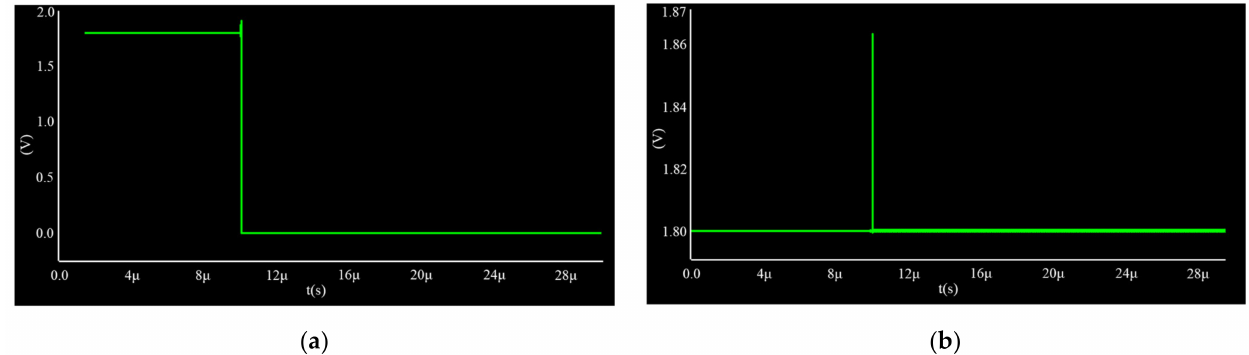
Figure 7. The output signal by transient simulation ( a ) fault-free; ( b ) fault with gate-source short with the M 1